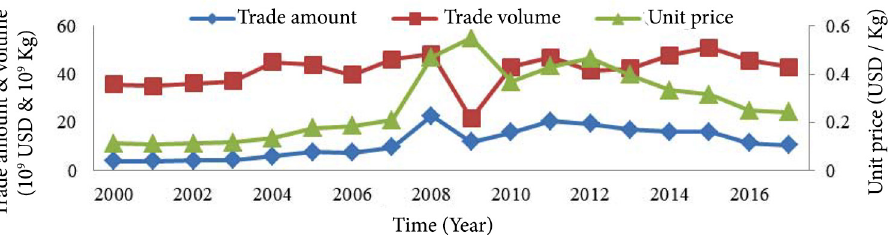
Figure 3. Changes in potassium salt trade from 2000 to 2017